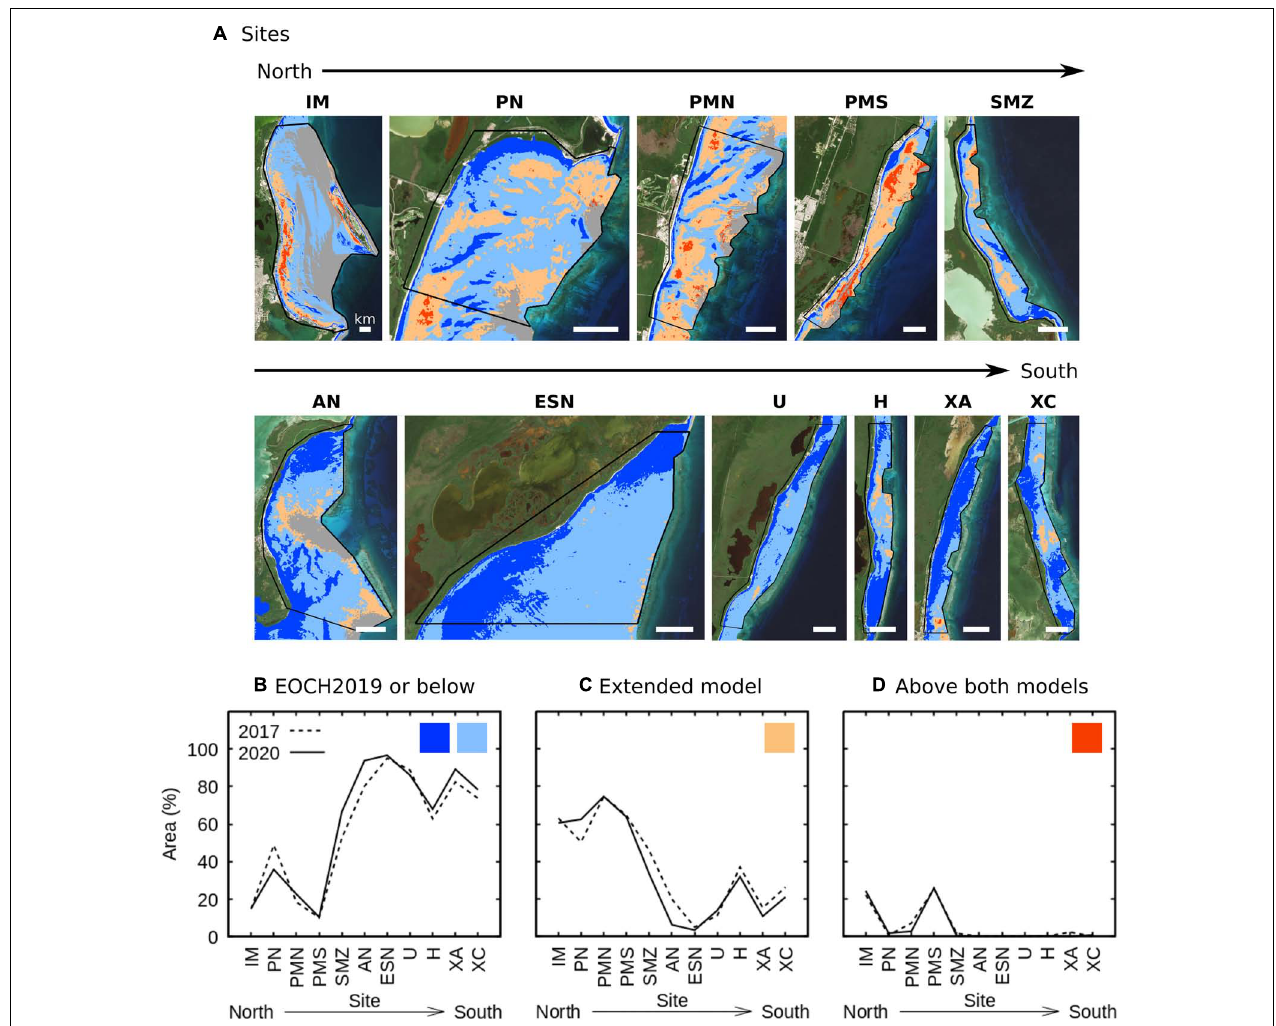
FIGURE 13 | Relative areas of different LAI-depth regimes, restricted to canopies of LAI > 2, found at (A) the eleven sites of interest. Colours indicate which categories are included corresponding to Figure 3 . (B) Relative area where estimated LAI was less than or consistent with EOCH2019 at the depth of occurrence, (C) where estimated LAI corresponded to the range defined by the extended model, (D) where estimated LAI was greater than expected by either